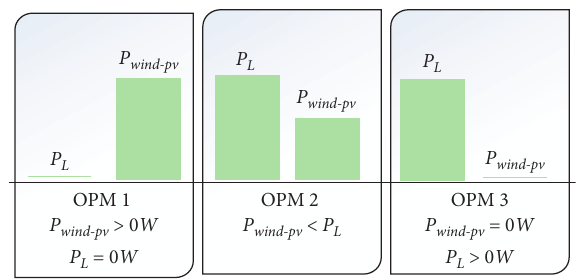
Figure 4: Operating modes described in the steady-state simulation